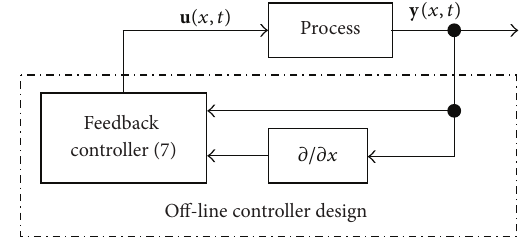
Figure 1: The structure of distributed P-sD state-feedback con-